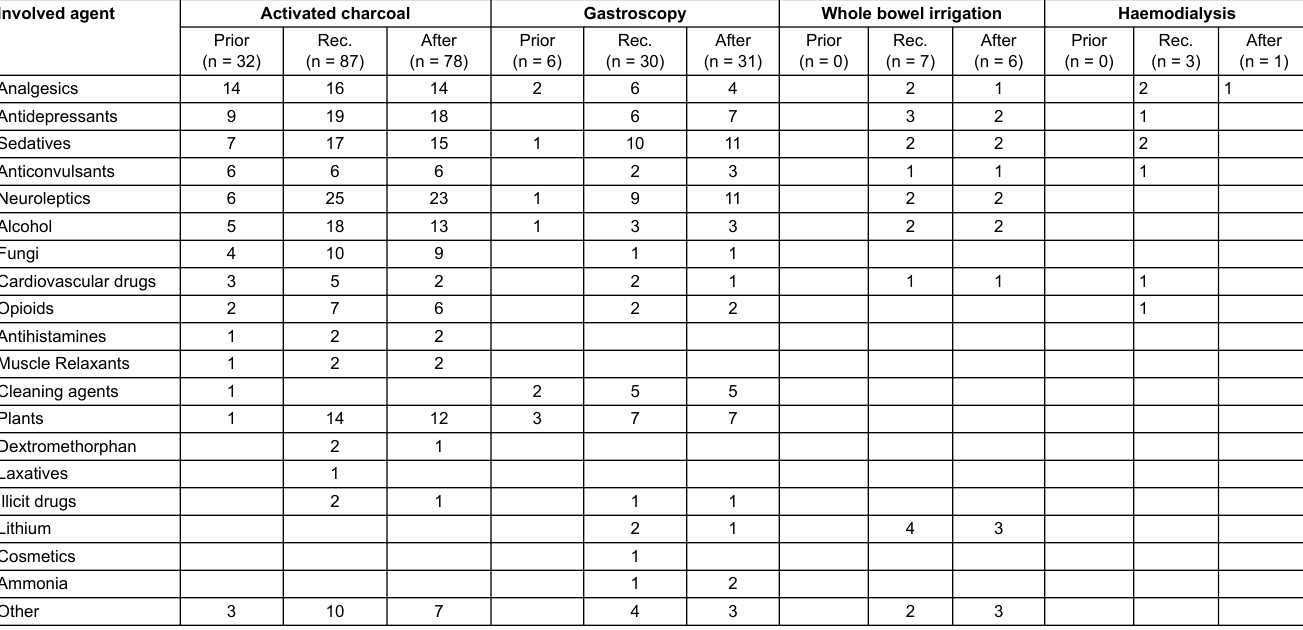
After = after consultation; Prior = before consultation; Rec. =